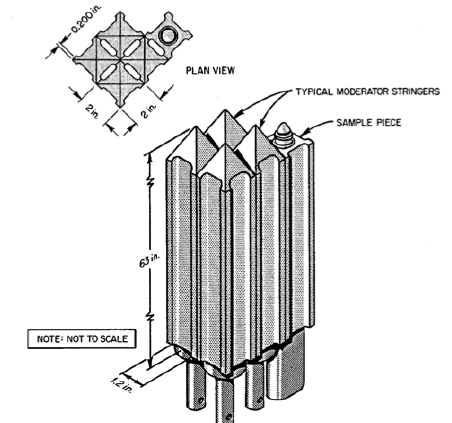
Figure 1. Dimensions and Arrangement of the Graphite Stringers